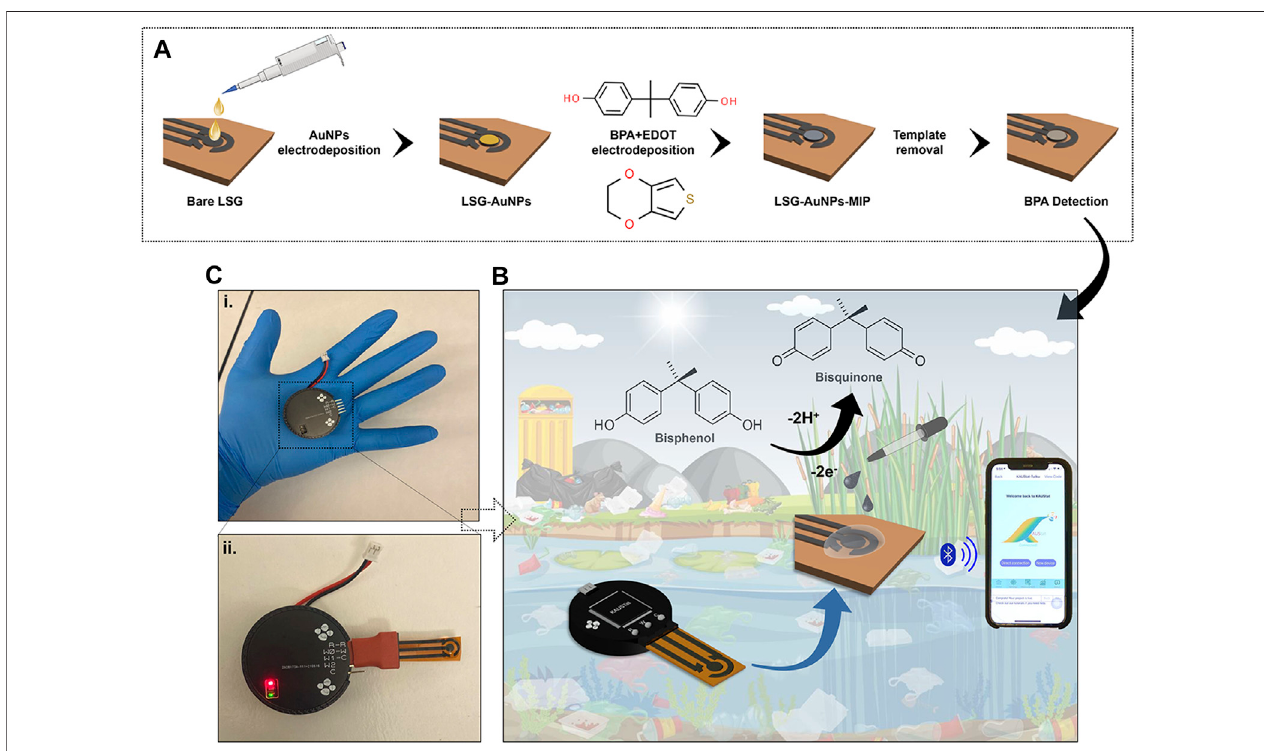
FIGURE 1 | (A) Preparation of the molecular imprinted laser-scribed graphene (LSG) sensor including electropolymerization of gold nanoparticles (AuNPs), 3,4-ethylenedioxythiophene (EDOT) monomer in the presence of bisphenol A (BPA), and template removal to create BPA cavities. (B) Schematic illustration of the portable potentiostat attached to the AuNPs/LSG sensor and connected to a smartphone via Bluetooth for detecting BPA in environmental samples. (C) The pictures of (i) the potentiostat, (ii) the device combined with the LSG-MIP sensor. Red light indicates an active Bluetooth connection.